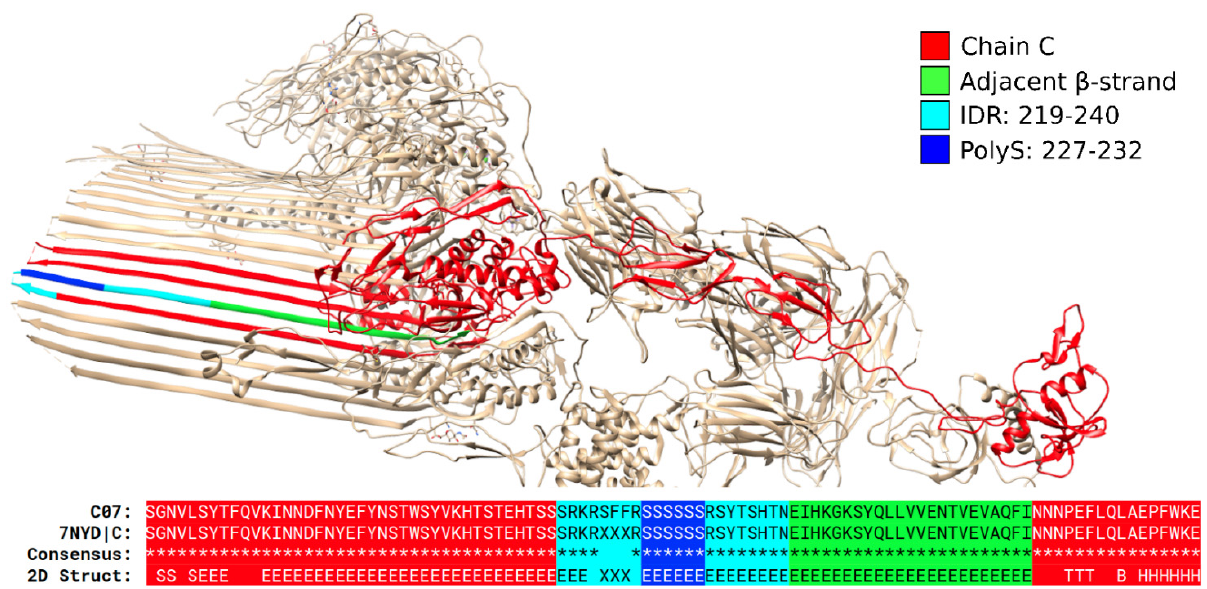
Figure 5. A polyS in CO7 is part of a β -sheet . Structure of protein C07 (UniProt: P10643; PDB:7NYD chain C). The polyS (which can be extended according to our definitions to a polyRS region) is part of a long strand of an antiparallel β -sheet.